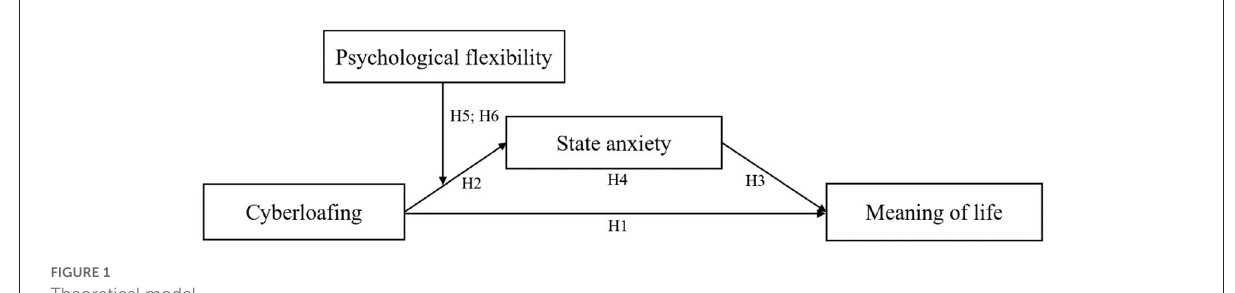
FIGURE1 Theoretical